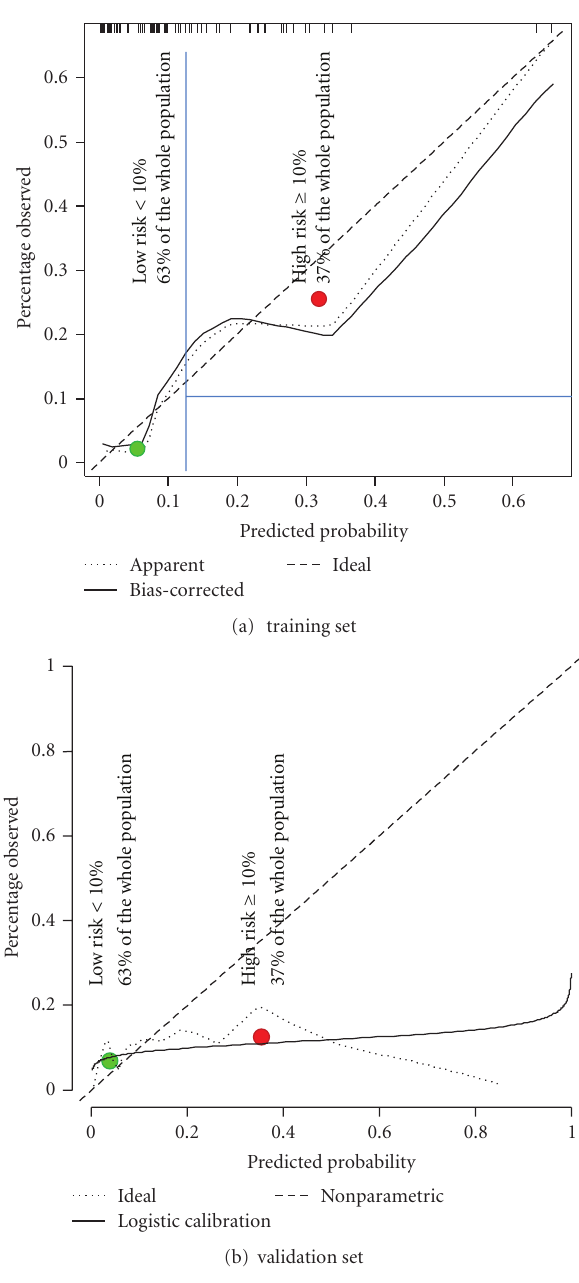
Figure 3: Calibration of the model to predict